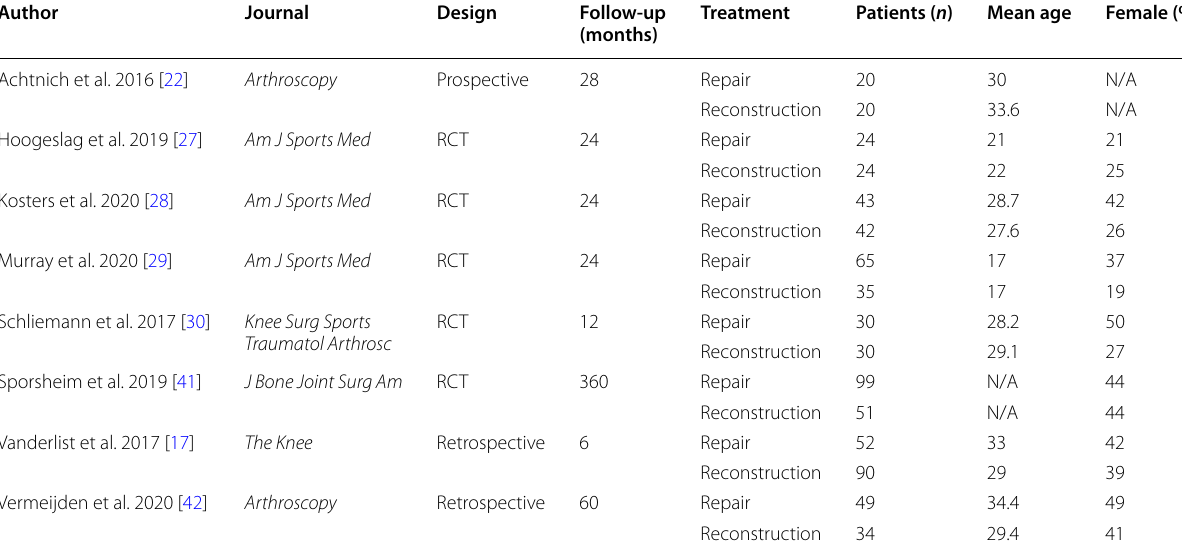
Table 1 Study generalities and patient demographics